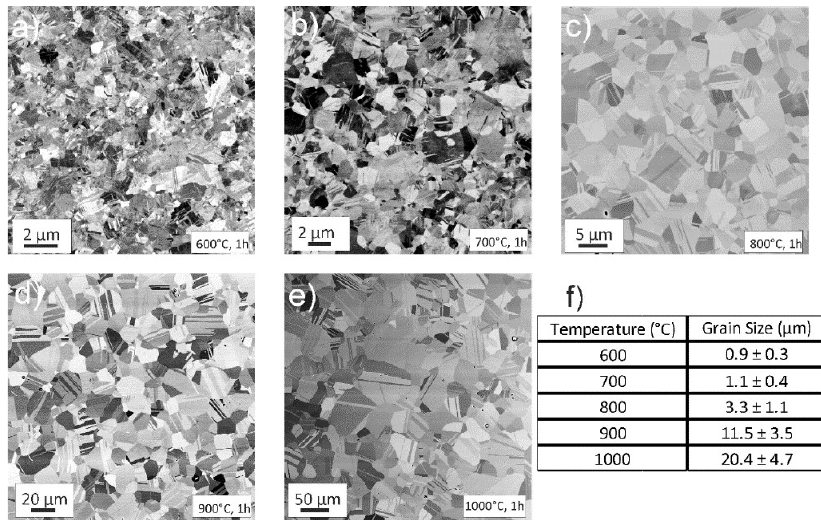
Figure 7. BSE-SEM images depicting the microstructure after 1h annealing treatments at, ( a ) 600 °C, ( b ) 700 °C, ( c ) 800 °C, ( d ) 900 °C, and ( e ) 1000 °C. In all cases, the microstructure is fully recrystallized, ( b ) 700 ◦ C, ( c ) 800 ◦ C, ( d ) 900 ◦ C, and ( e ) 1000 ◦ C. In all cases, the microstructure is fully